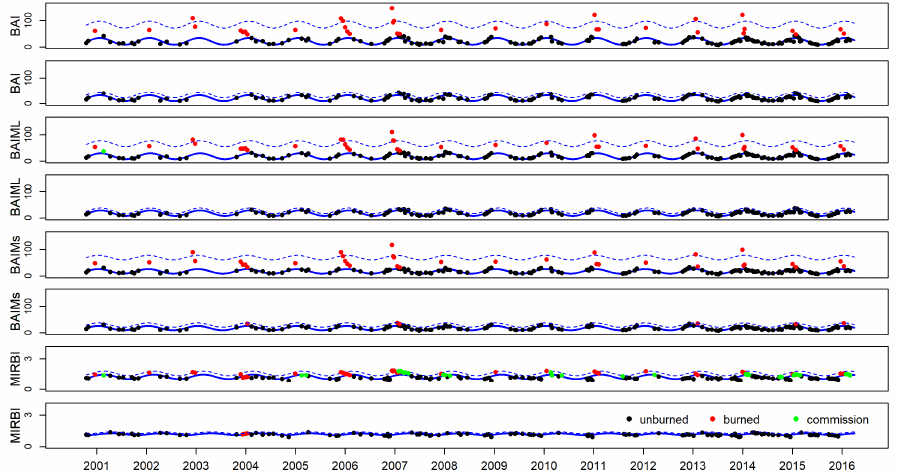
Figure 4. Demonstration of harmonic model fit before and after burned area detection for a single pixel, based on different spectral indices with burned pixels having higher values than unburned pixels. The black points are unburned pixels, the red points are burned pixels, the green points are commission pixels, the blue curve is the harmonic model, and the dashed blue line is the threshold for detecting burned pixels.